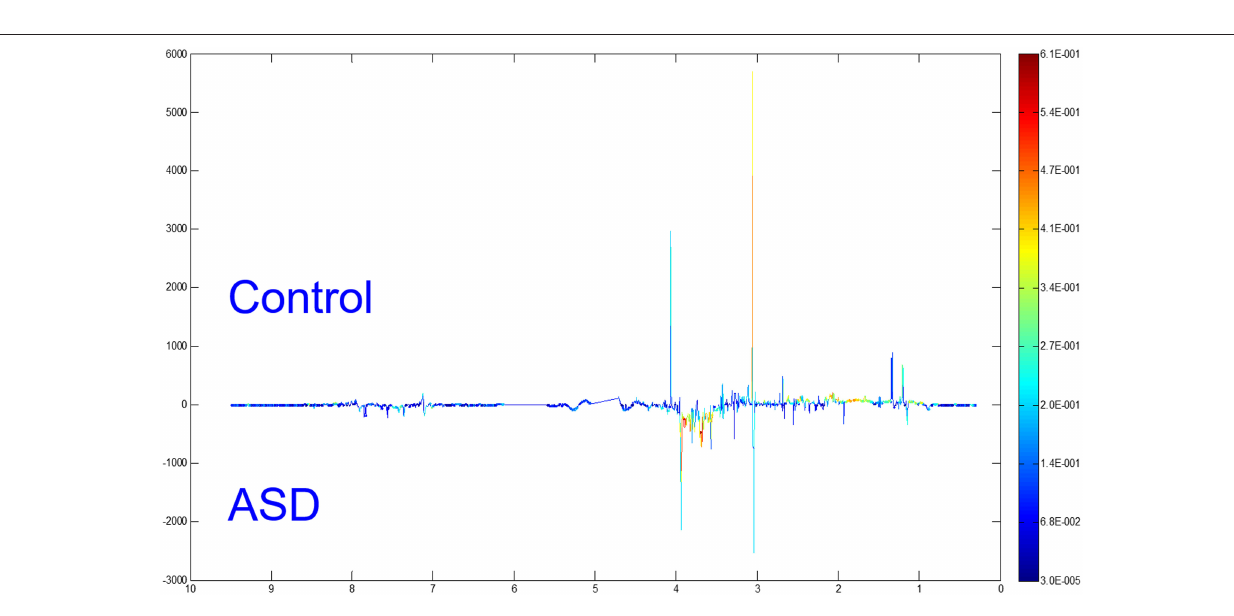
FIGURE 4 | OPLS-DA model: a polychromatic correlation coefficient loading